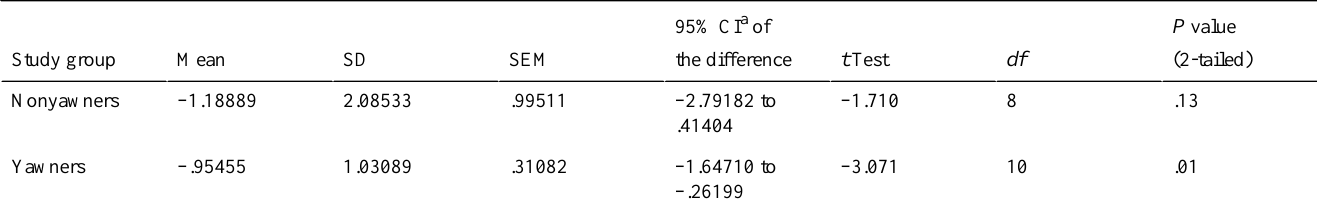
Table 4. Paired-samples test for nonyawners and yawners (sample 1 – sample